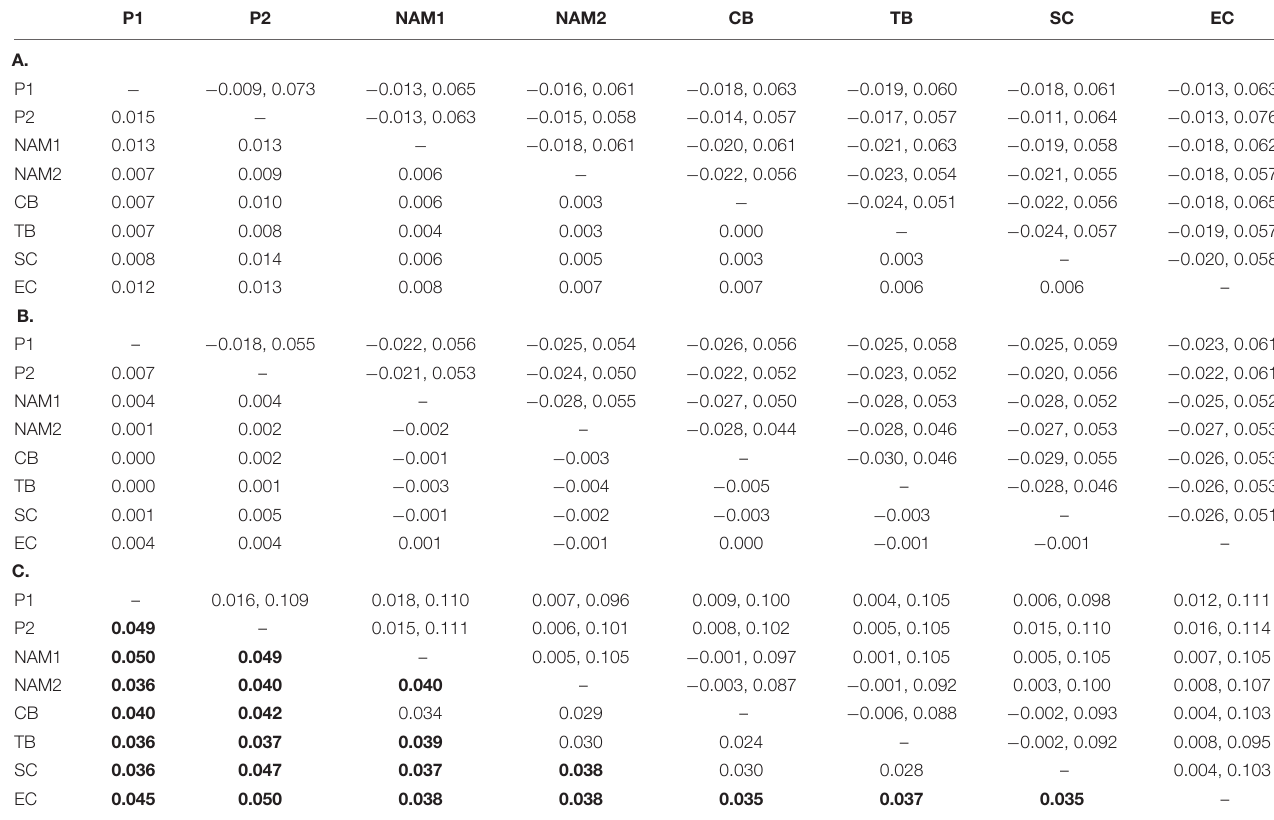
TABLE 3 | Estimates of pairwise genomic differentiation (F ST , below diagonal) and 95% confidence intervals (above diagonal) for all sampling sites/pools, based on (A) full (outlier ad neutral loci), (B) neutral (neutral loci only), and (C) outlier (outlier loci only) datasets. Statistically significant results in